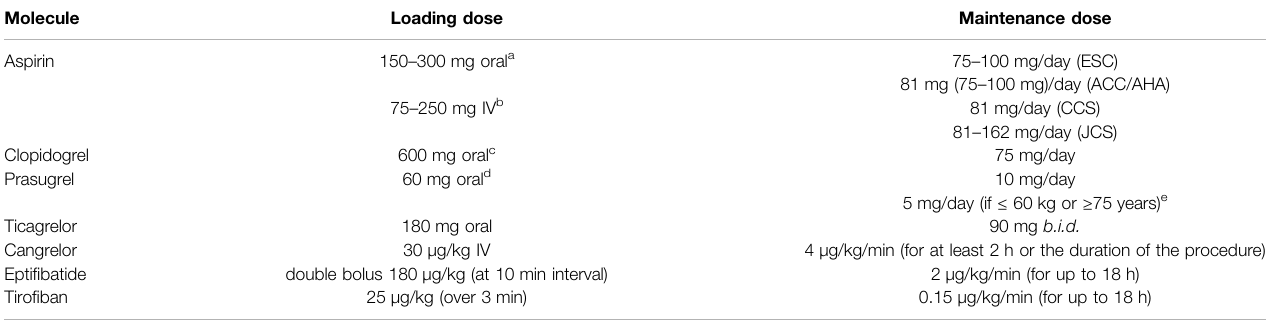
TABLE 1 | Recommended doses of antiplatelet agents in ACS